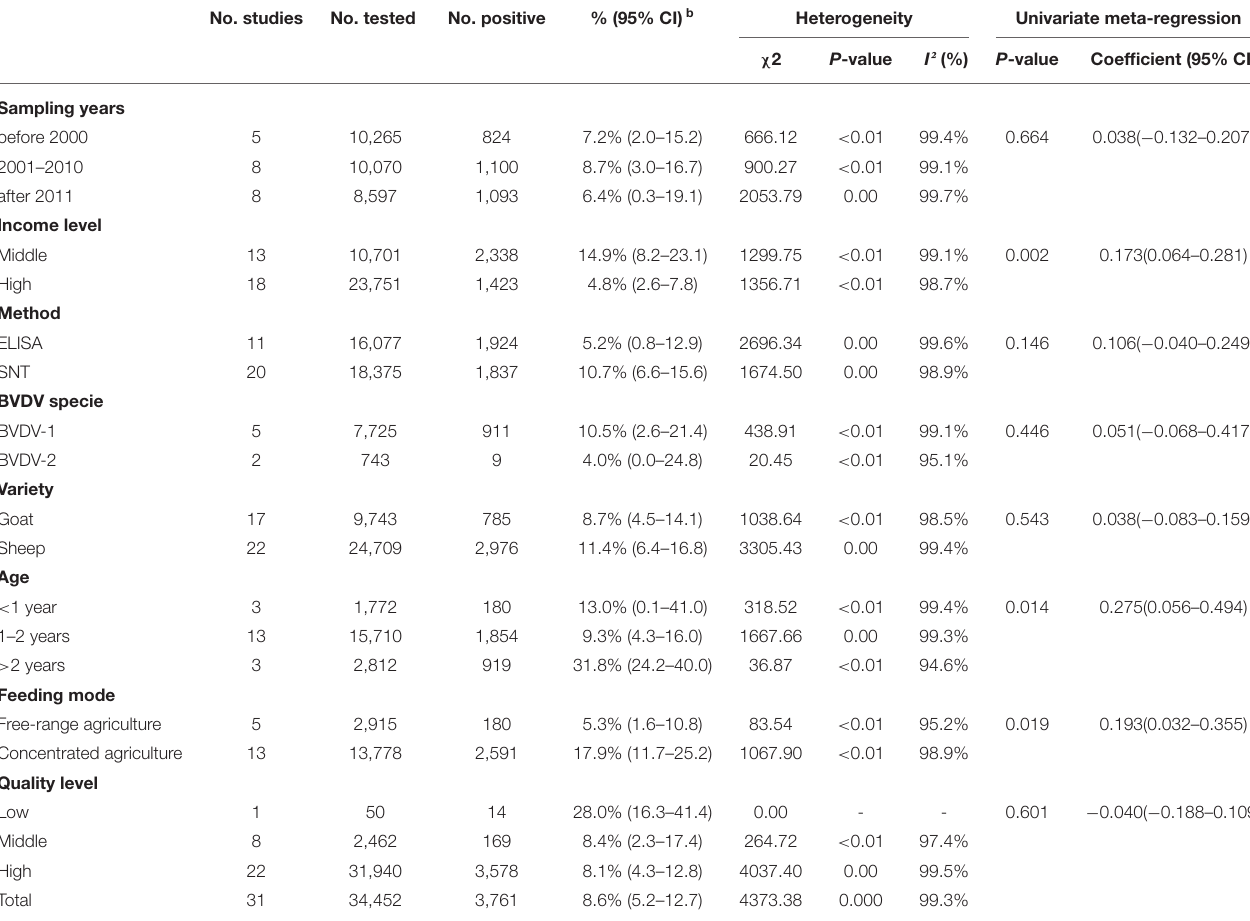
TABLE 4 | Association of different variables in the prevalence of BVDV infection in sheep and goats worldwide (Immunological methods). No. studies No. tested No. positive % (95% CI) b Heterogeneity Univariate